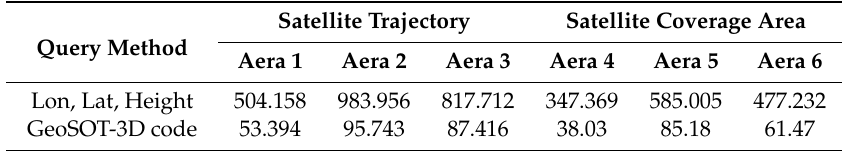
Table 3. Query results (ms).